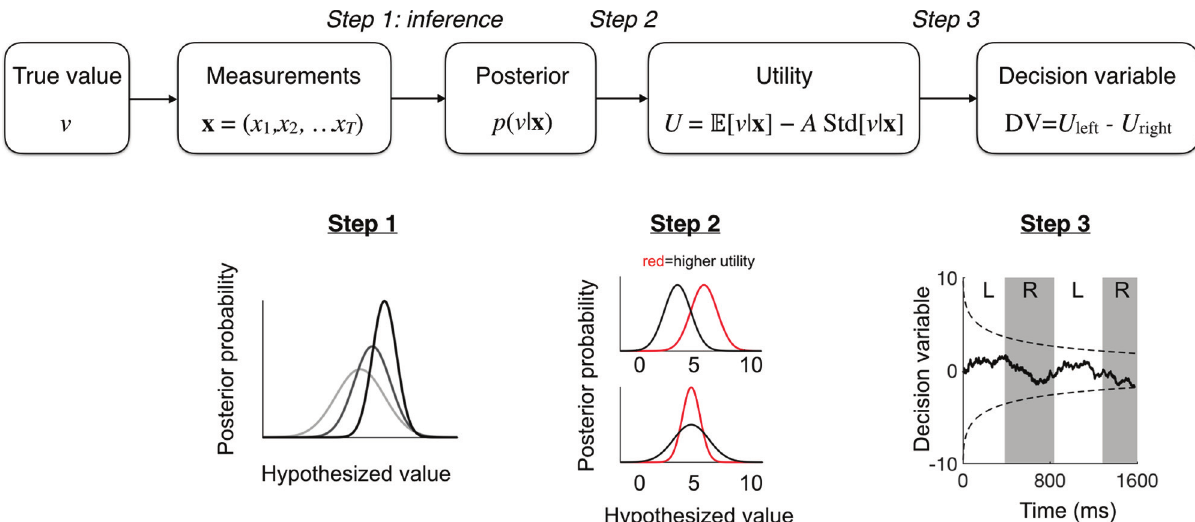
Fig 2. Posterior-Utility-Choice model. The PUC model describes how an agent maps noisy measurements of value to a decision variable. Top: Flow diagram of the model. Bottom: Components of the model. Step 1: The agent computes a posterior distribution over hypothesized value. As viewing time increases (darker colors), the posterior distribution shifts from the prior towards the true value, and becomes narrower. Step 2: Utility incorporates both the mean and the standard deviation of the posterior over value. Both higher mean and lower standard deviation are preferred. Utility is evaluated separately for each item. Step 3: Evolution of the decision variable on an example trial. L and R denote fixations on the left or the right item. The decision variable, DV, is the utility difference of the two items. A decision is made when DV crosses the collapsing bound (dashed).